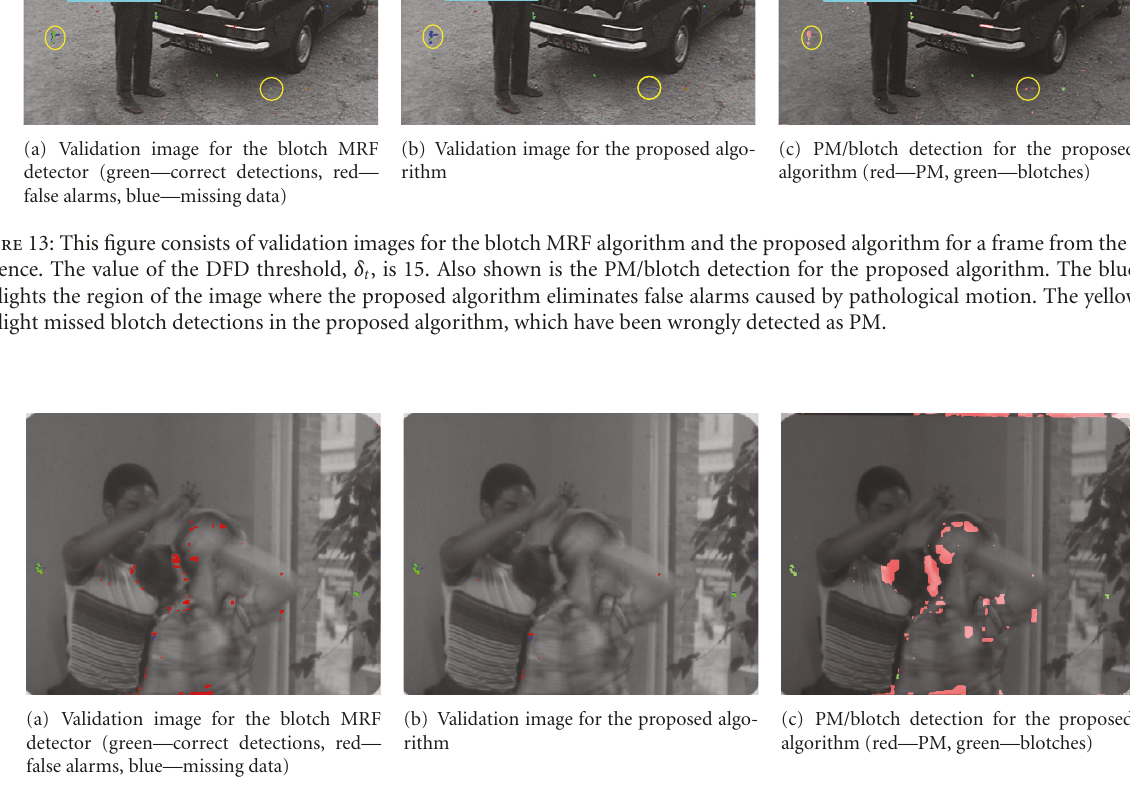
Figure 14: This figure consists of validation images for the blotch MRF algorithm and the proposed algorithm for a frame from the “dance” sequence, as well as the corresponding PM/blotch detection for the proposed algorithm. The value of the DFD threshold, δ t , is 15. Using the proposed algorithm reduces the number of false alarms in the region of the head of the female dancer.